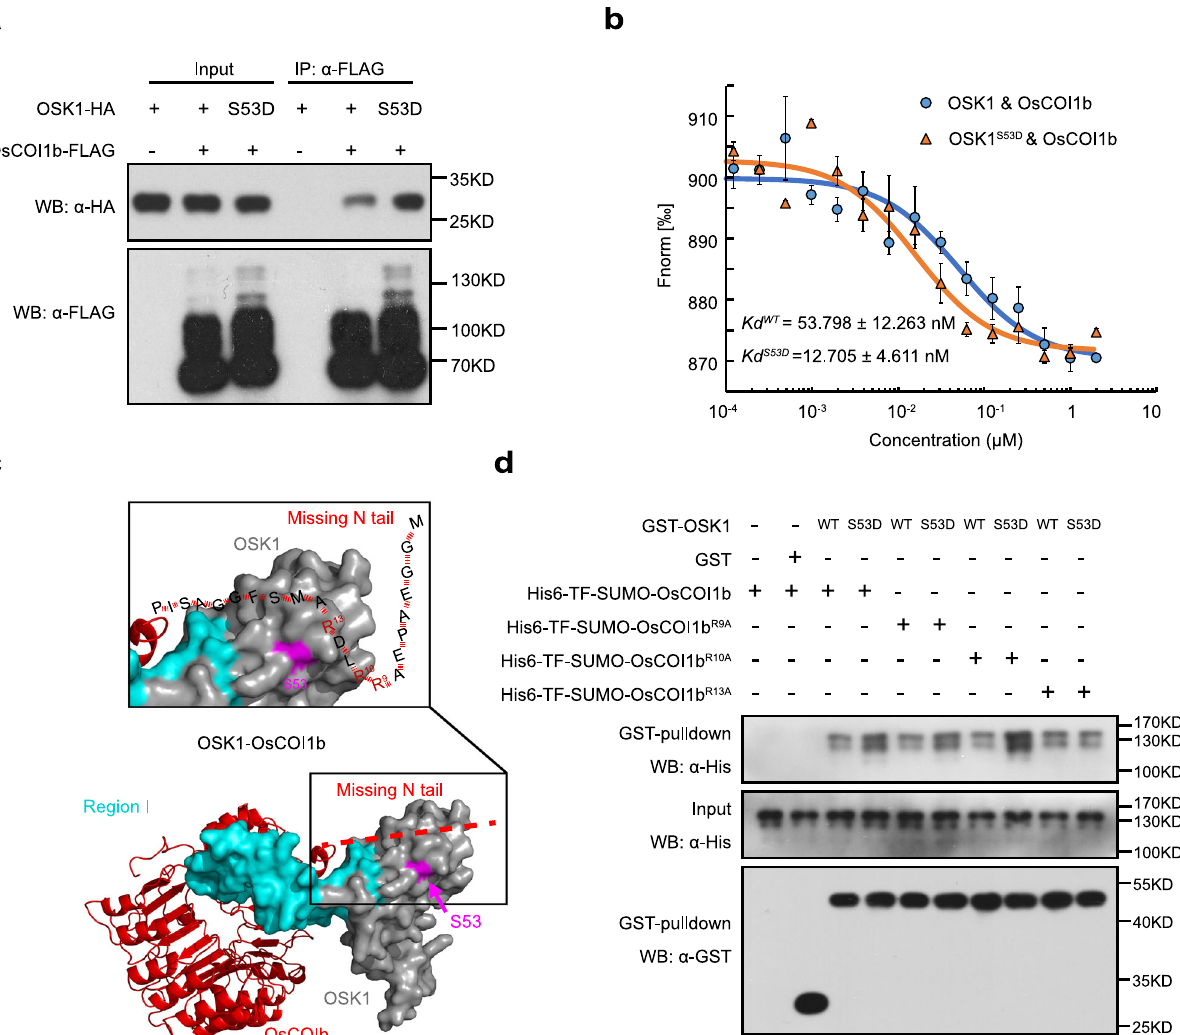
Fig. 6 The enhanced binding af fi nity of phosphomimic OSK1 S53D to COI1b is dependent on the Arg 13 residue in COI1b. a OSK1 S53D -HA bound to OsCOI1b-FLAG much stronger than OSK1-HA in co-IP assays. OSK1-HA and OSK1 S53D -HA were individually co-expressed with OsCOI1b-FLAG in rice protoplasts. The immunocomplex and input proteins were analyzed by immunoblotting using anti-HA and anti-FLAG antibodies. The experiments were independently repeated 3 times with similar results. b His6-OSK1 S53D bound to OsCOI1b much stronger than His6-OSK1 in MST assays. OsCOI1b bound to His6-OSK1 S53D with a K d of 12.705± 4.611 nM while to GST-OSK1 with a K d of 53.798 ± 12.263nM. Data are shown as means± SE ( n = 3 technical replicates). c The 3-D structure of OsCOI1b-OSK1 was constructed via homology modeling with the ASK1-COI1-JAZ complex (PDB: 3OGM) as a template. The N-terminal fl exible tail of OsCOI1b missing from the template was arbitrarily labeled. The N-terminal tail containing multiple positive-charged Arg residues is predicted to be adjacent to Ser 53 in OSK1. d OsCOI1b R13A had a similar binding af fi nity to OSK1 and OSK1 S53D . In vitro-puri fi ed His6-TF-SUMO- tagged OsCOI1b R9A , OsCOI1b R10A and OsCOI1b R13A were individually incubated with GST-OSK1 and GST-OSK1 S53D , respectively. After GST pulldown